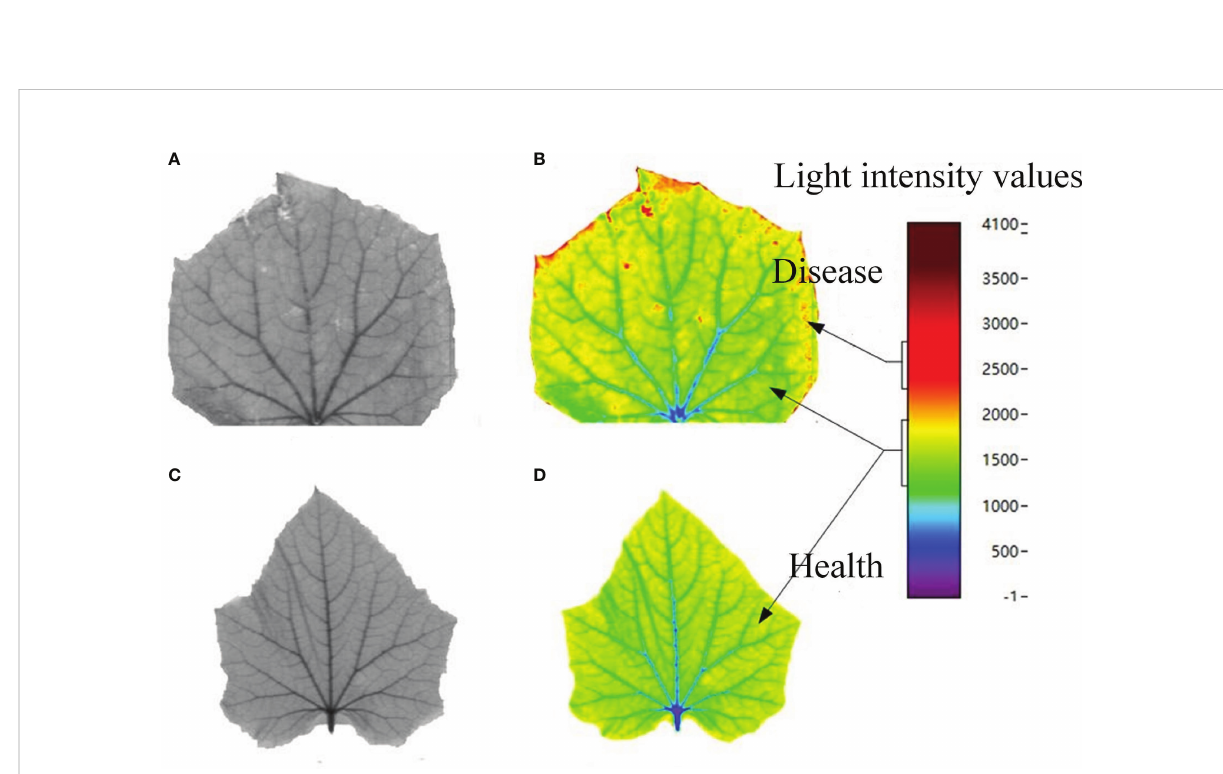
FIGURE 9 NIR characteristic images at 1395.186nm. (A) cucumber powdery mildew; pseudo-colour images of (B) cucumber powdery mildew and (D) healthy cucumber samples; (C) Healthy samples of